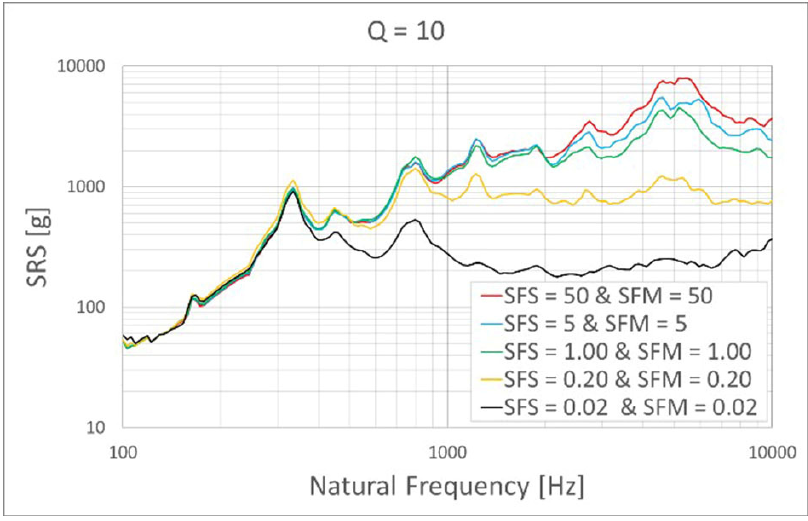
Figure 8. The effect of contact stiffness on the SRS response.